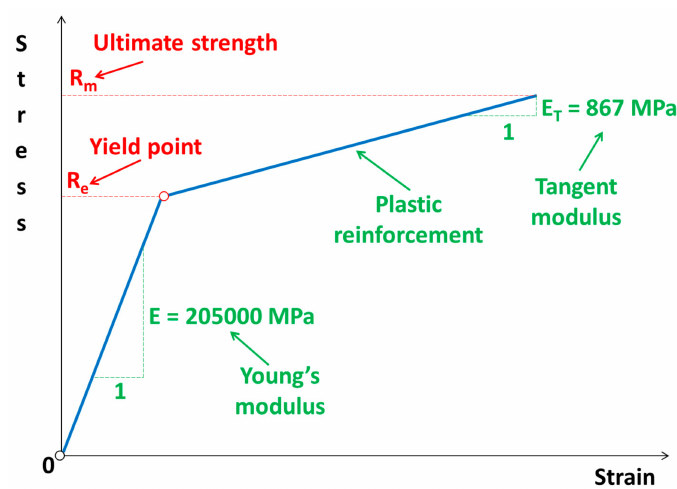
Figure 4. Bilinear elastic–plastic physical material model.